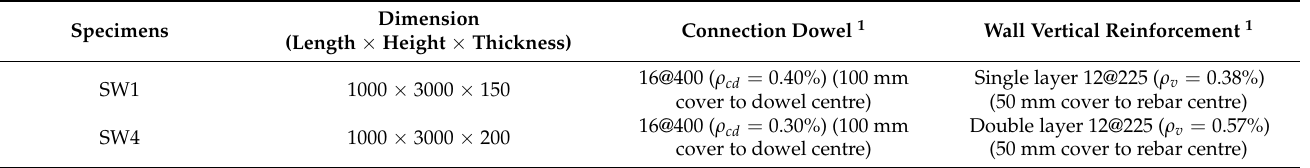
Figure 5. Illustration of SW1 and SW4 [14]. Table 1. Summary of two precast wall units SW1 and SW4 [14].